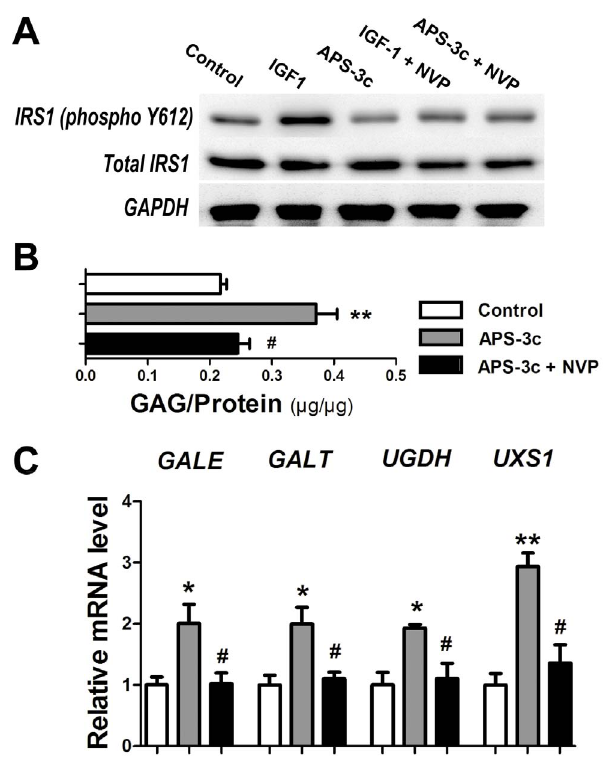
Figure 7. NVP-AEW541 attenuated GAG synthesis and UDP- sugar synthases (USSs) gene expression induced by APS-3c. A, Phosphorylated and total insulin receptor substrate 1 (IRS-1) was detected in the chondrocytes treated with 50 ng/ml recombinant human insulin like growth factor 1 (IGF-1) or 10 m g/ml Angelica sinensis polysaccharides (APS-3c) for 30 min, or pretreated with IGF1 receptor (IGF1R) inhibitor 1 m M NVP-AEW541 for 30 min and subsequently co- treated with IGF1 and NVP-AEW541 or APS-3c and NVP-AEW541